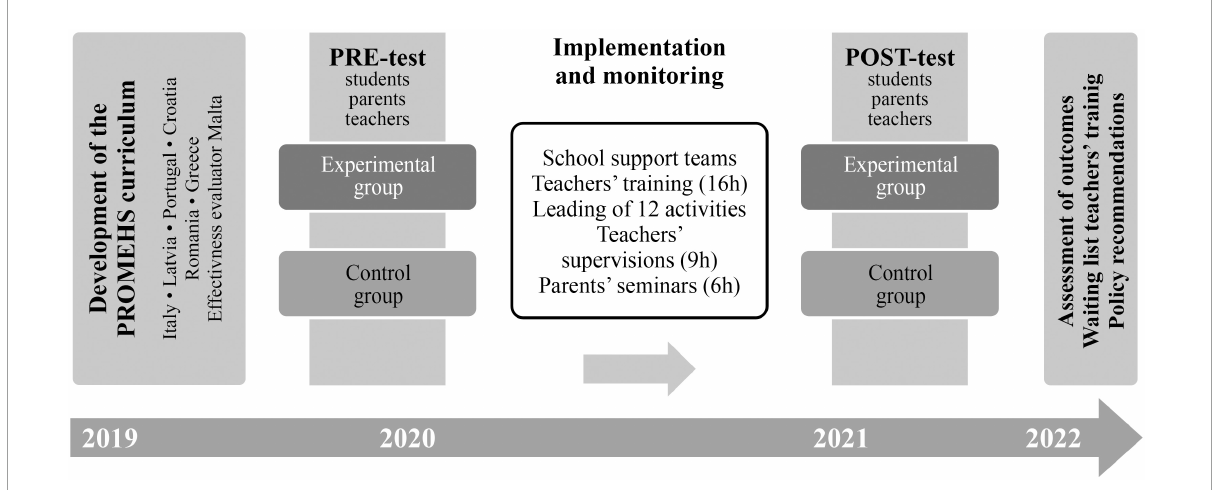
FIGURE1 Promoting Mental Health at Schools project’s timeline and